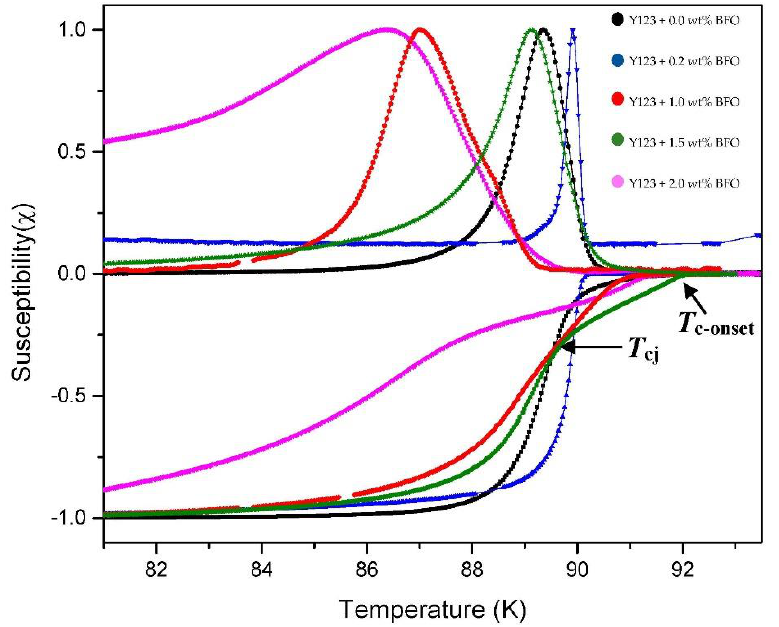
Figure 4. Graph of the normalized susceptibility of χ’ and χ” against the temperature of the Y-123 + x wt.% of BiFeO 3.